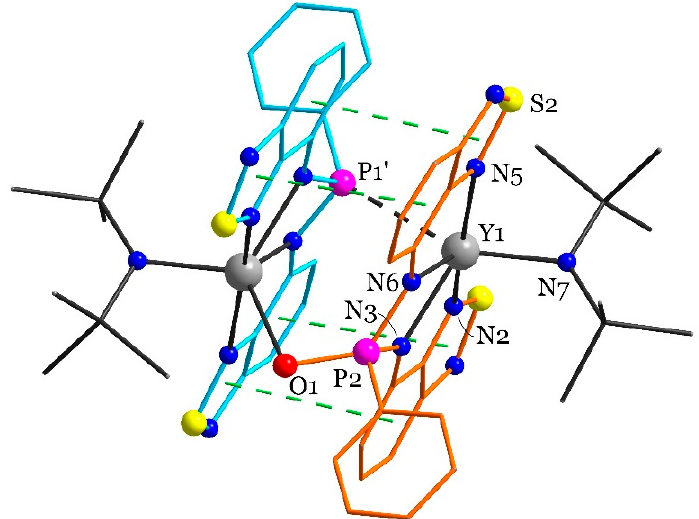
Figure 2. The structure of 4 2 · Et 2 O according to XRD. Solvate ether molecules, disordered parts, and hydrogen atoms are omitted; one independent molecule is shown. Different L ligands are coloured with orange or blue. A partially occupied oxygen is located at both equivalent P atoms, but it is shown only at one of them. Green dashed lines indicate π - π interactions. Selected distances (Å): Y1–